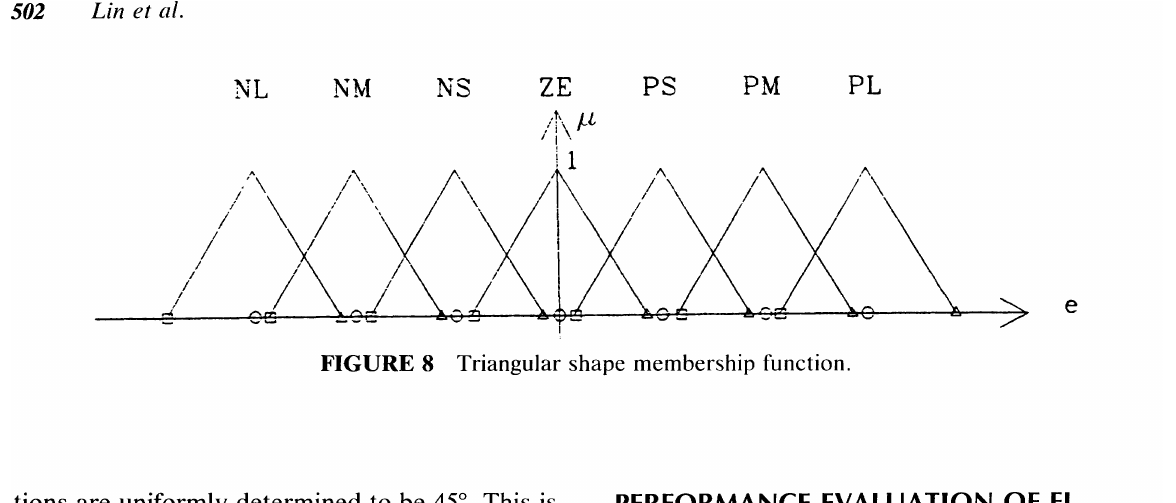
FIGURE 8 Triangular shape membership